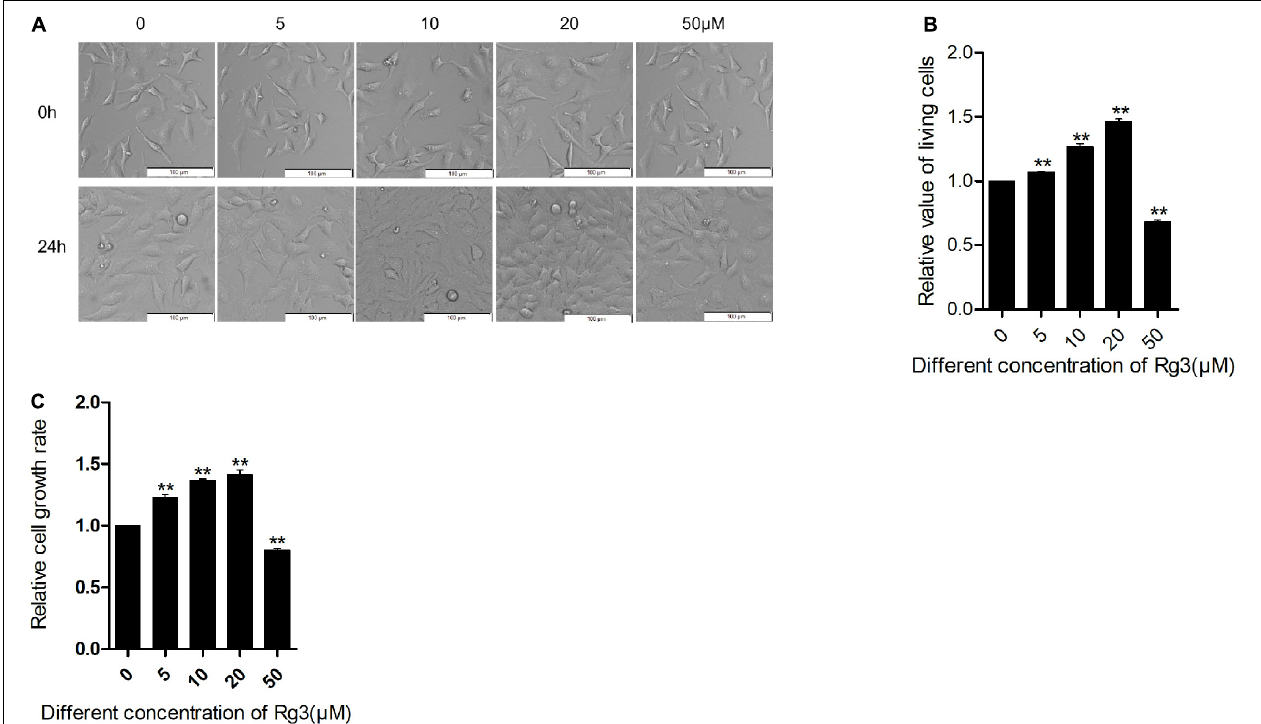
FIGURE 1 | Low concentrations of Rg3 promote cell proliferation. HeLa cells were treated with various concentrations of Rg3 for 24 h in 10% FBS. (A) The number and morphology of cells. Cell images were captured using a phase contrast microscope (100 × ). Scale bar, 100 µ m. (B) Viable cell count performed using trypan